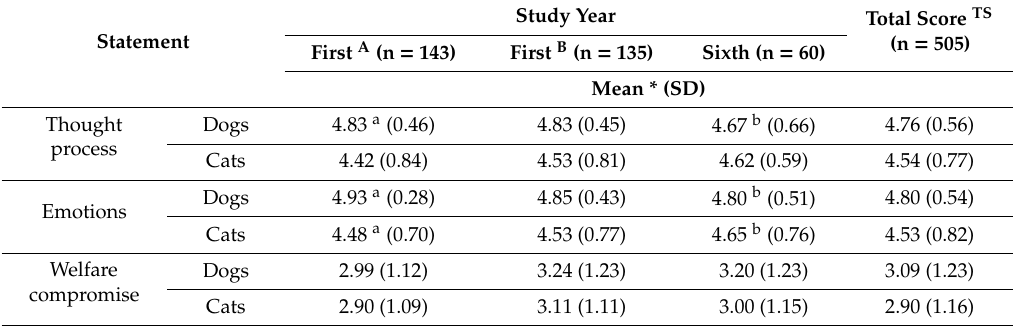
Table 2. Student opinions towards the level of cognitive abilities in dogs and cats and their welfare